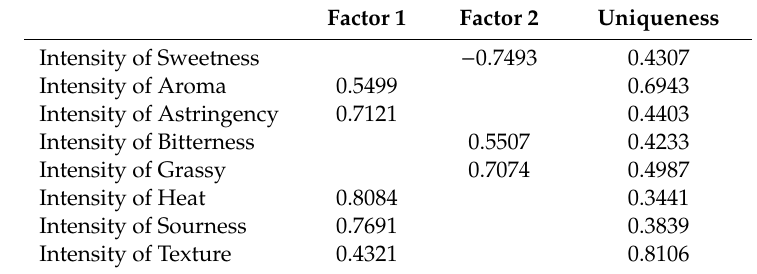
Table 3. Exploratory Factor Analysis (EFA) using orthogonal (Varimax) rotation: factor loadings. EFA results on the nine sensory attributes of 12 microgreens species appraised through the untrained consumer test. Two main sensorial dimensions were successfully extracted from the nine sensory attributes. Factor loadings indicate the correlation between the attribute and the latent construct. Uniqueness shows the proportion of variance unaccounted for by the latent dimensions. Factor 1 Factor